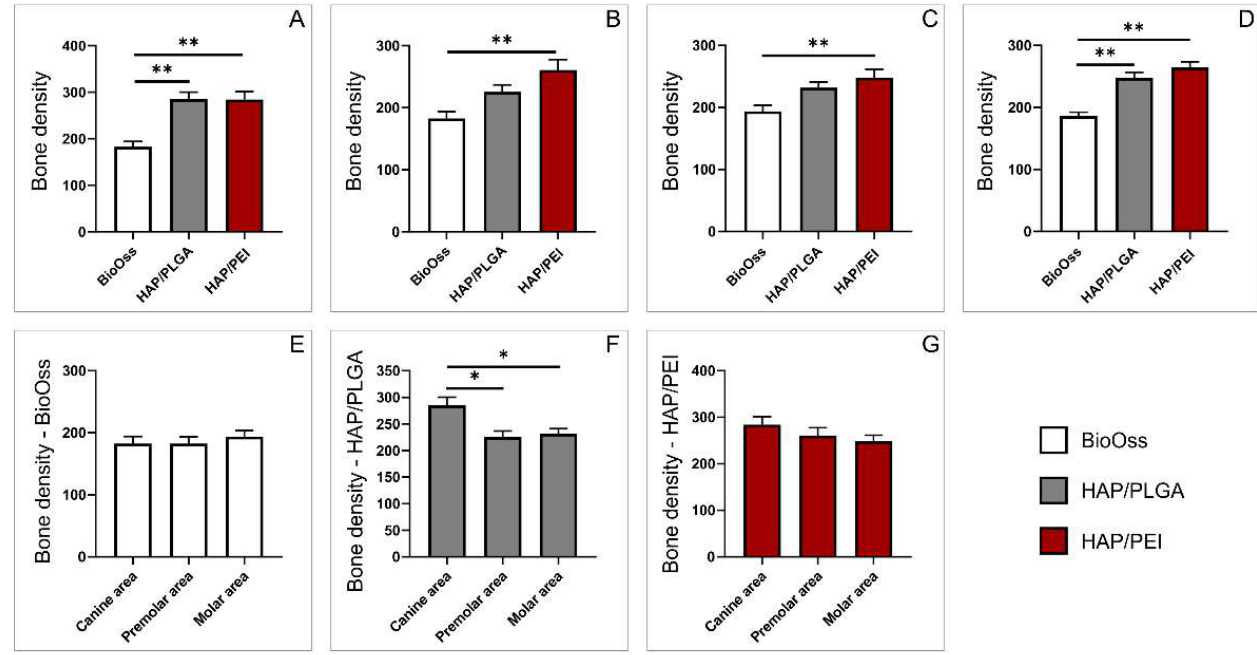
Figure 1. Radiological assessment of bone density obtained by CBCT: ( A ) canine area, ( B ) premolar area, ( C ) molar area, ( D ) whole mandibula, ( E ) BioOss graft, ( F ) HAP/PLGA graft, ( G ) HAP/PEI graft. The values are mean ± standard error of the mean (SEM), * denotes a significant difference p < 0.05, ** denotes a significant difference p < 0.01.